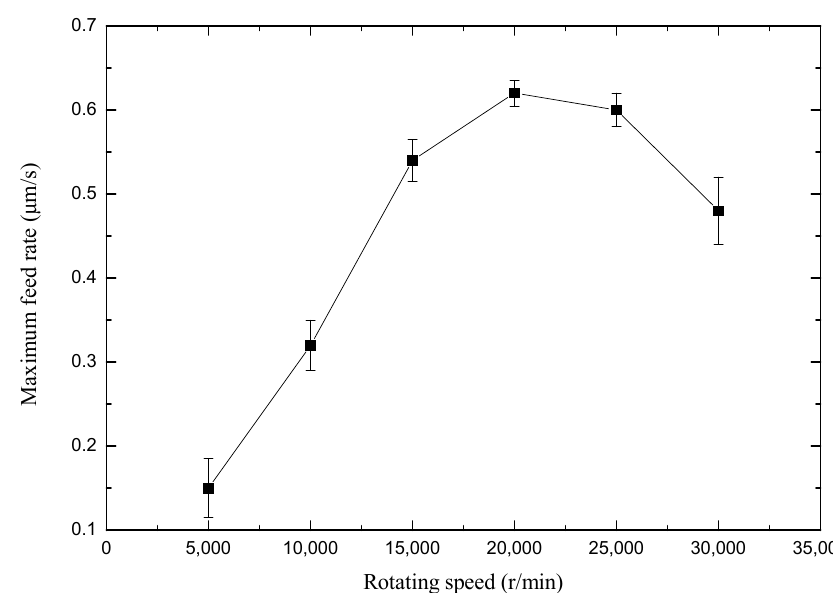
Figure 9. Maximum feed rate along with rotating speed of the micro-spiral electrode.